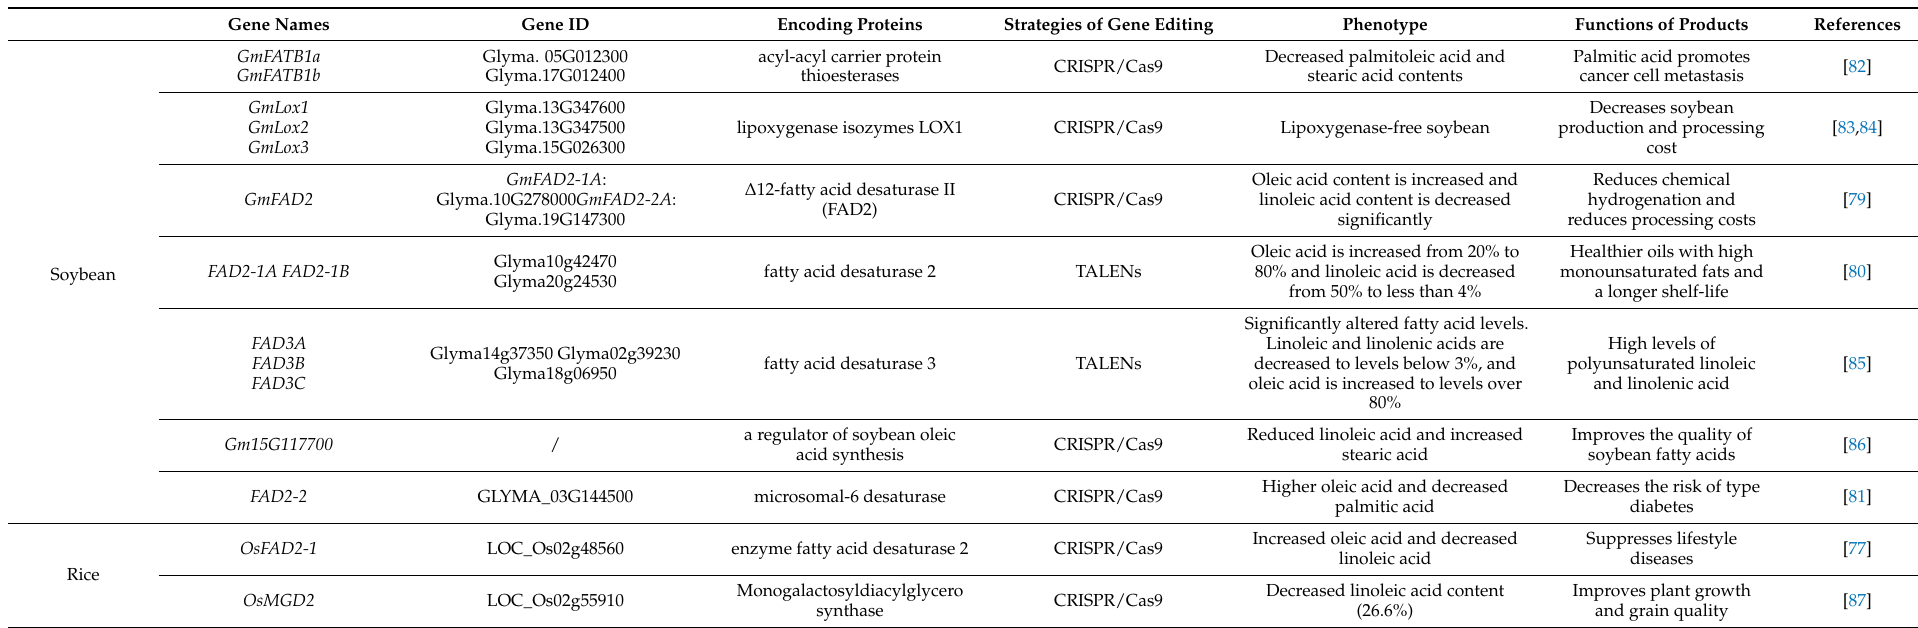
Table 2. Gene resources of lipid biosynthesis and their applications in crop improvement based on gene